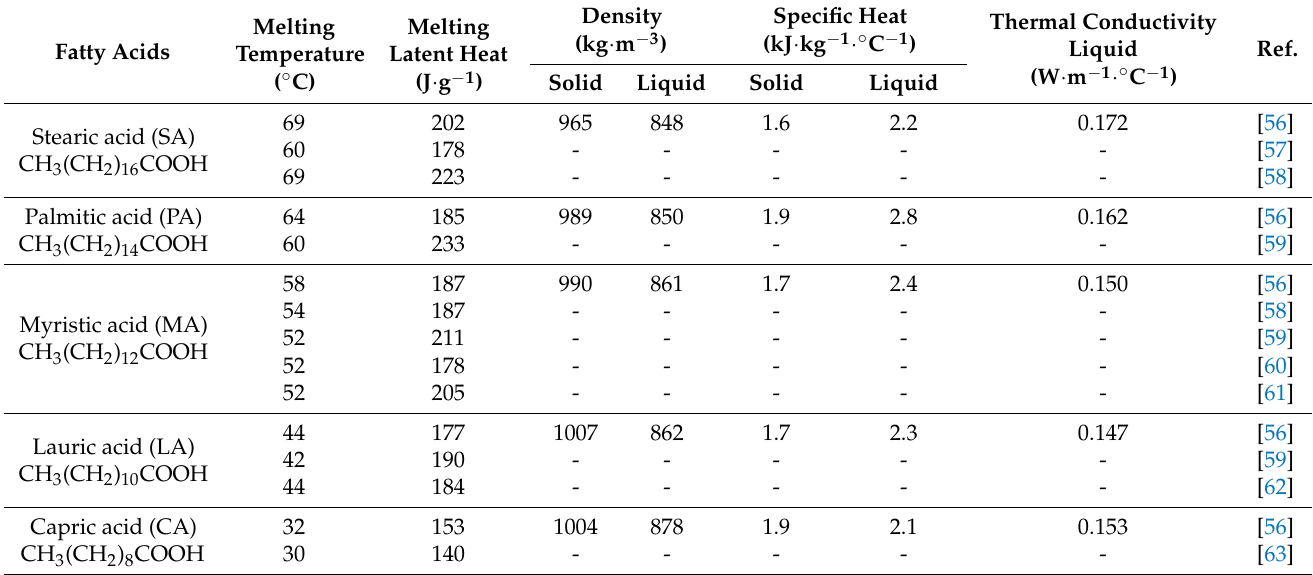
Table 1. Thermal properties of some fatty